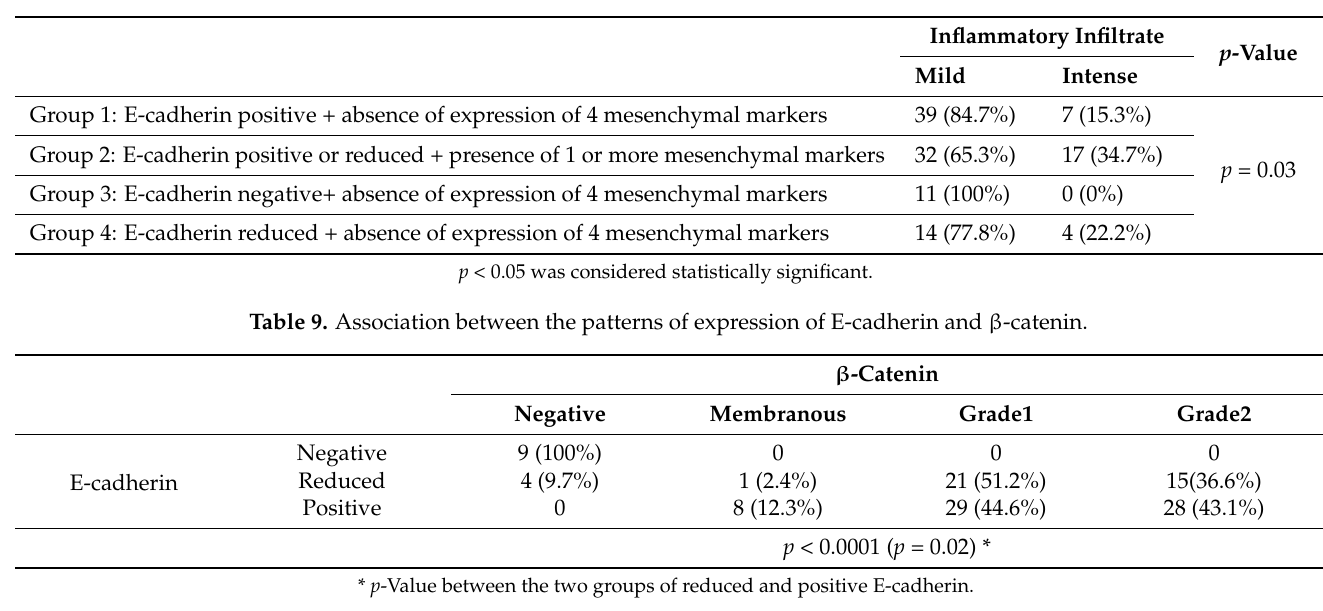
Table 8. Association between the different groups and the degree of inflammatory infiltrate assessed by IHC.